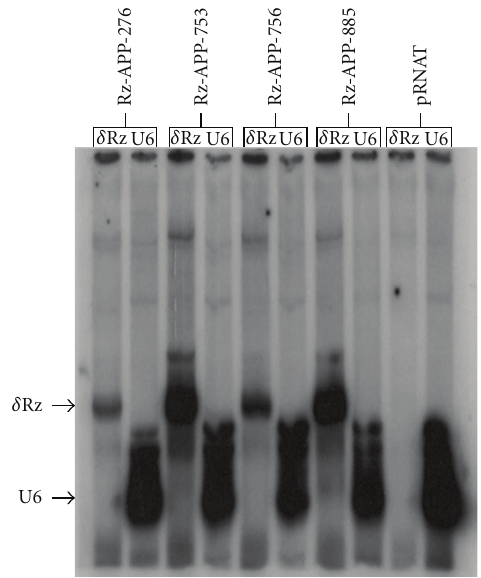
Figure 3: Expression of APP-SOFA-HDV ribozymes in the HEK cell line. Primer extension analysis of total cellular RNA from cells transfected with four selected APP-SOFA-HDV ribozymes from the ribozyme collection (APP-SOFA-HDV-Rz276, APP-SOFA-HDV- Rz753, APP-SOFA-HDV-Rz756, and APP-SOFA-HDV-Rz885). Transcripts corresponding to HDV-ribozymes were detected with HDV-Rz primers (5 (cid:2) -GGGTCCCTTAGCCATGCGCGAACG-3 (cid:2) ). U6 primer (5 (cid:2) -GGCCATGCTAATCTTCTCTG-3 (cid:2) ) was also used as a positive control, which yielded signals corresponding to endo- genous U6 snRNA. Note that all of the 4 selected SOFA-HDV ri- bozymes were expressed (lanes 1 to 4). A pRNAT empty vector, was used as a negative control.